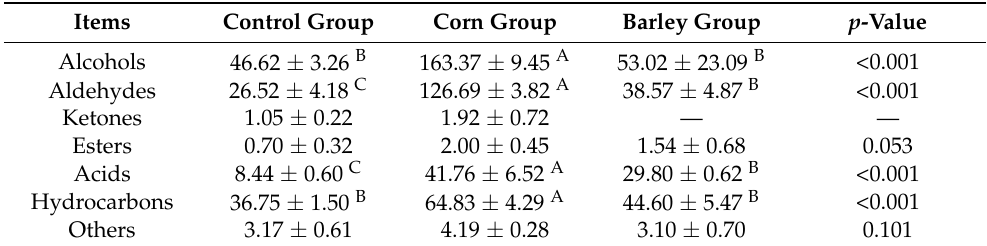
Table 11. Effects of different carbohydrate source diets on composition and content of volatile flavor compounds ( µ g/kg) in